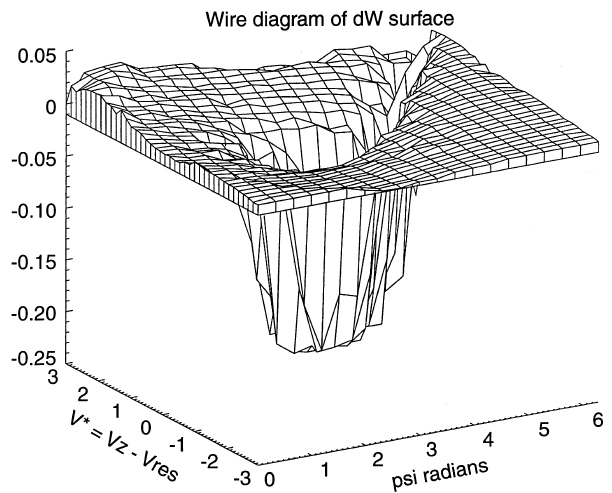
Fig. 23. Case D. Wire diagram of D W in the faller segment at t = 1.5 s, at z = ) 1000 km. The distinct bunch of trapped particles with D W < 0 is